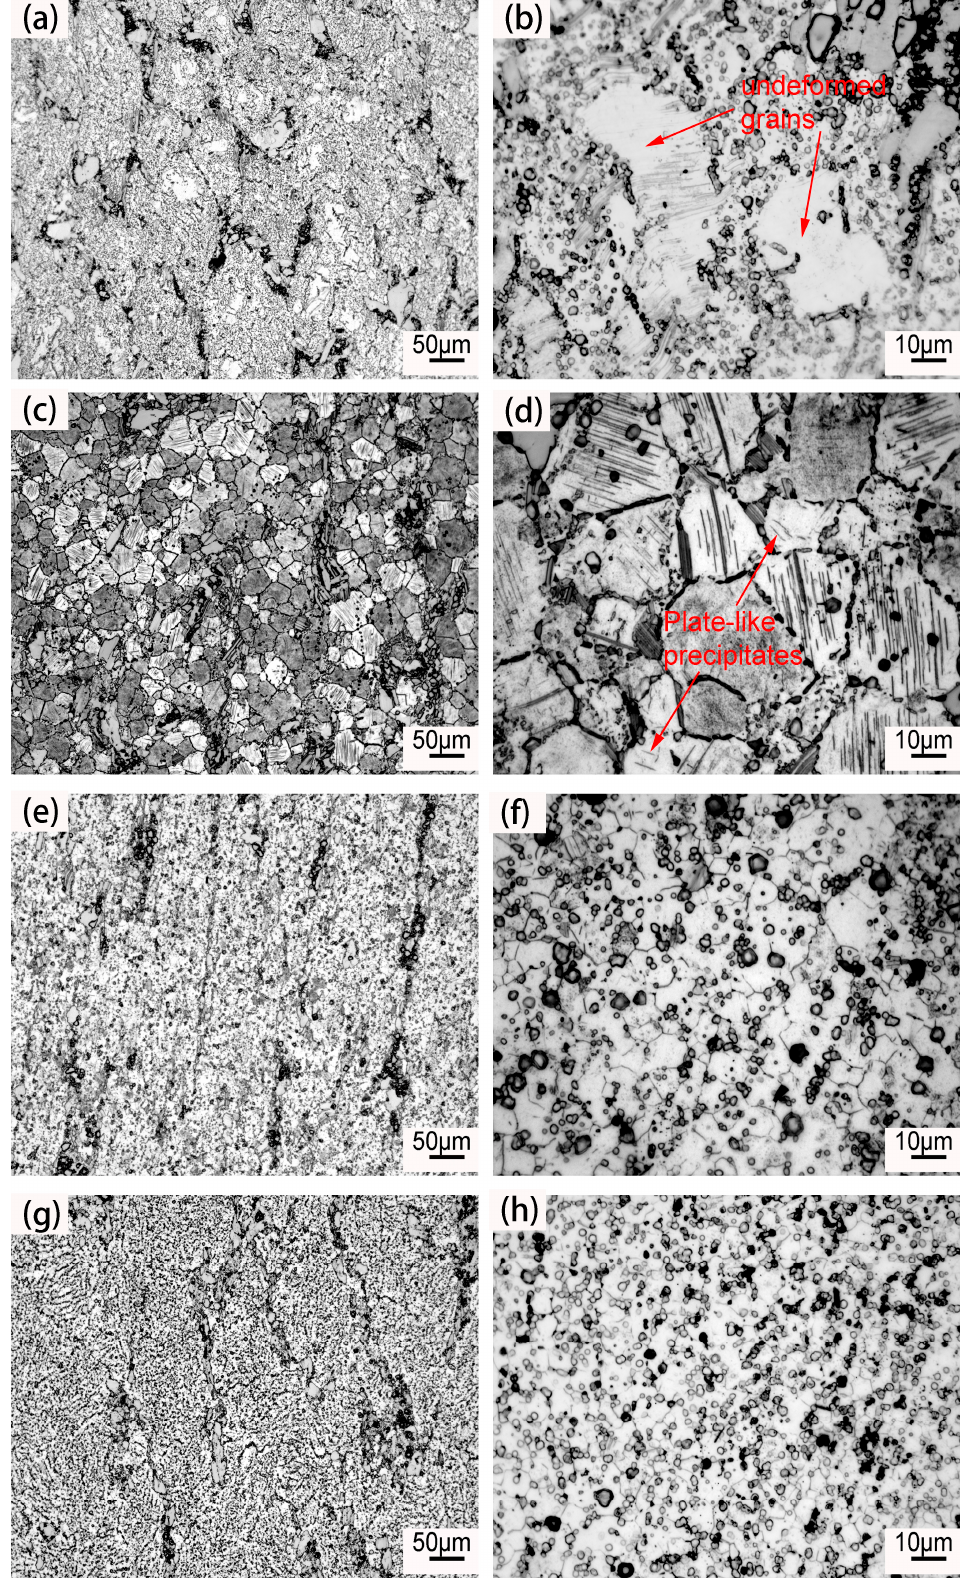
Figure 4. The OM images of MDFed alloy after different passes: ( a , b ) 1 pass, ( c , d ) 2 passes, ( e , f ) 3 passes, ( g , h ) 4 passes.